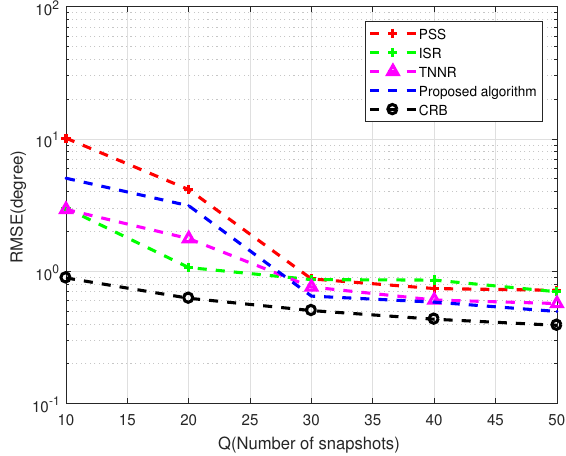
Figure 7. RMSE versus the number of snapshots for two uncorrelated targets.